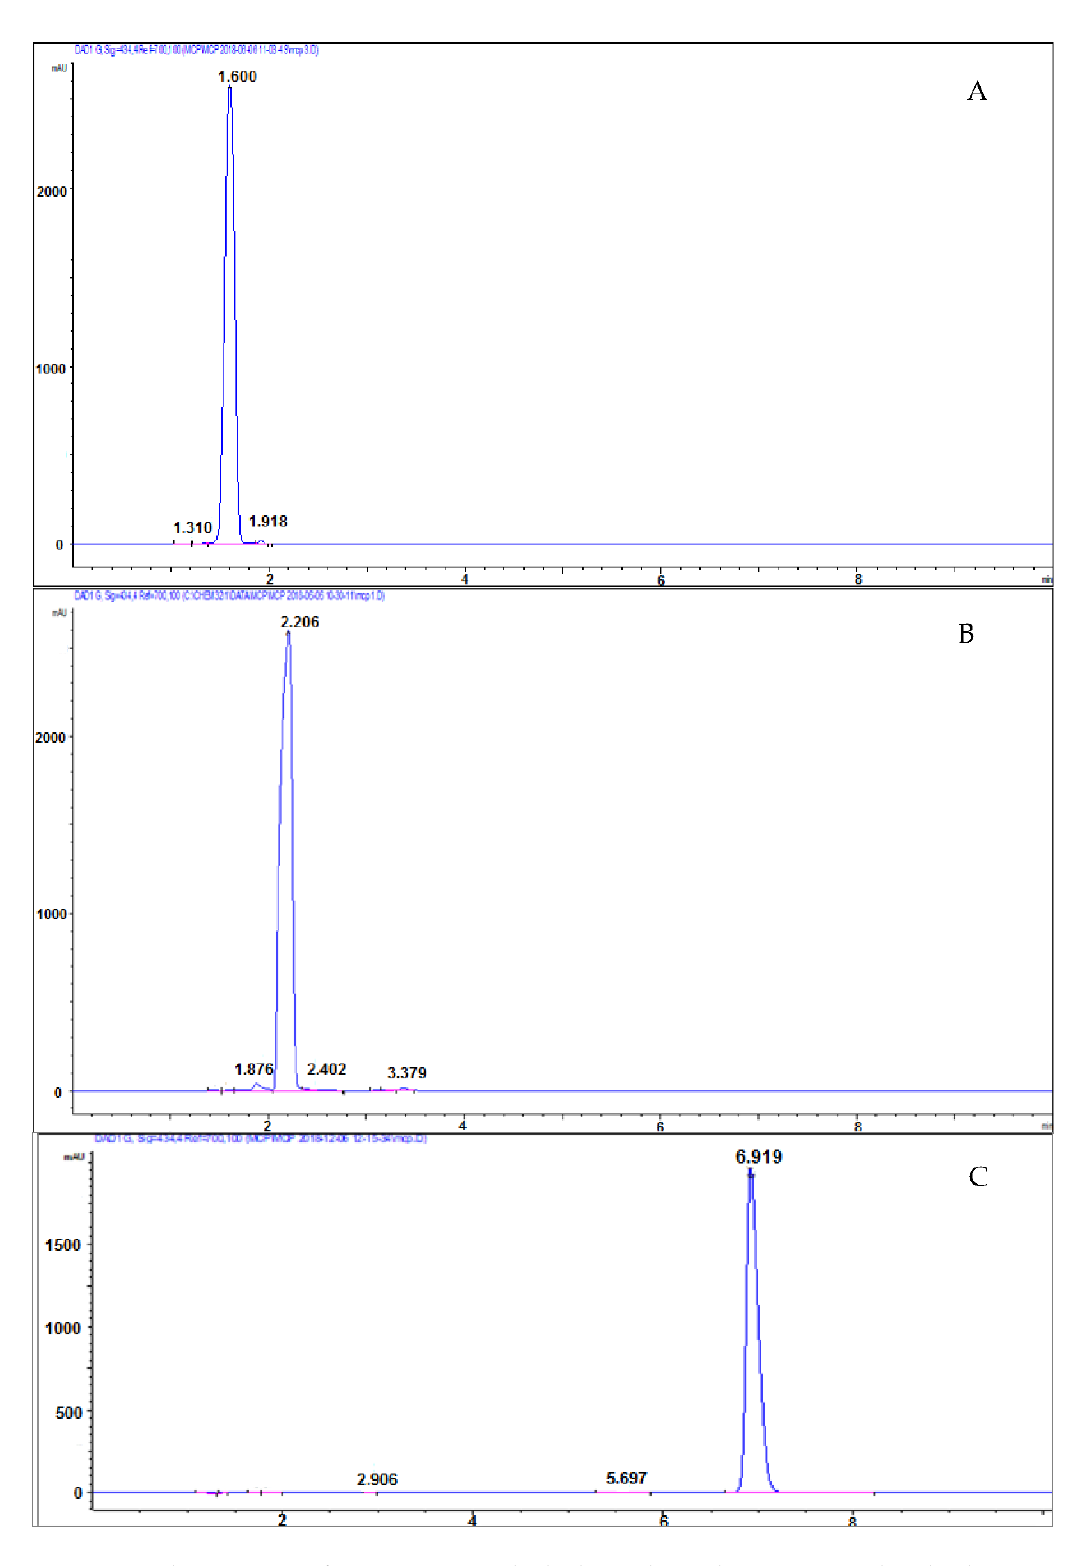
Figure 5. HPLC-DAD chromatogram of 2.5 mM mCP standard solution detected at 434 nm wavelength. Eluent composition: ( A ): 50% CH 3 COONH 4 ; ( B ): 60% CH 3 COONH 4 ; ( C ): 80% CH 3 COONH 4 .